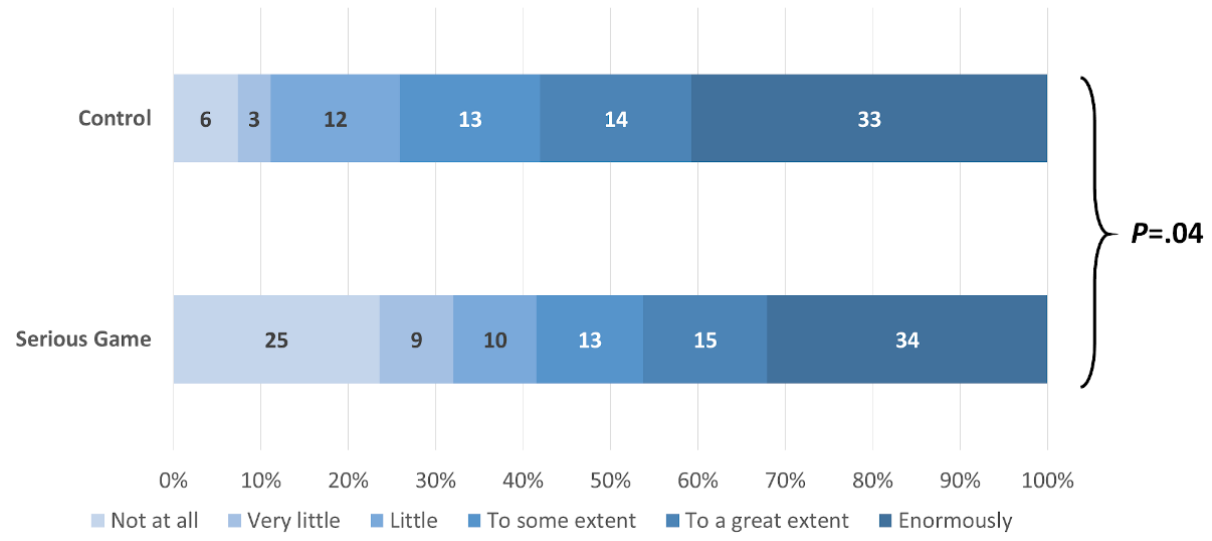
Figure 12. Magnitude of the willingness to protect oneself from asymptomatic